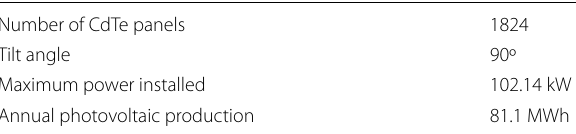
Table 18 Data for cadmium telluride photovoltaic system sizing for